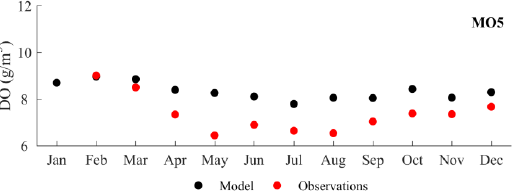
Figure 2. Comparison between model results and observations of sea surface elevation, water tem- perature, and salinity for MO1, MO2, MO3, and MO4 stations located at Mondego Estuary during the spring tide.